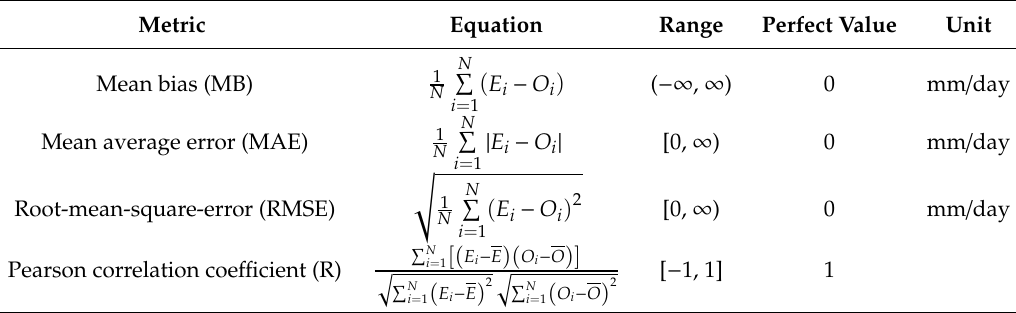
Table 2. Summary of metrics